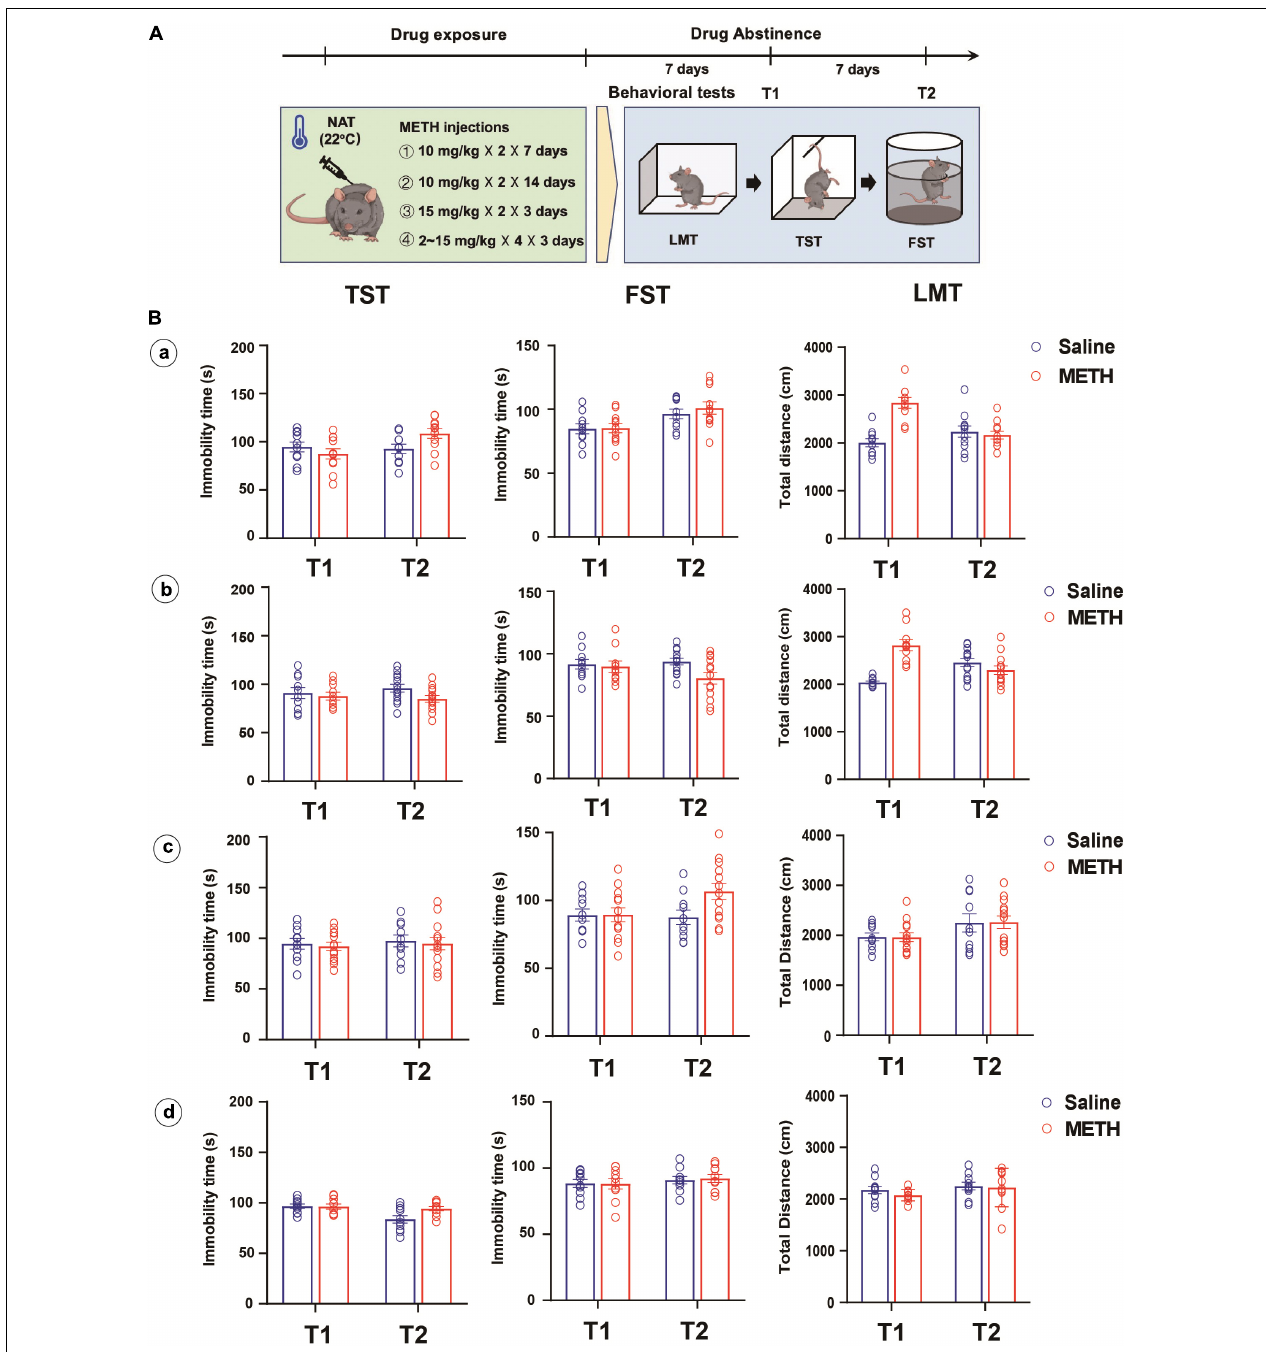
FIGURE 2 | Longer-term (10 mg/kg × 2, 7 and 14 days), higher dose (15 mg/kg × 4, 3 days) or escalating-dose (2–15 mg/kg, 3 days) regimen of METH treatments under normal ambient temperature (22 ◦ C) failed to induce depression-like behaviors in mice. (A) Timeline of drug treatment and behavioral tests. (B) Different METH treatment procedures ( a: 10 mg/kg × 2, 7 days; b: 10 mg/kg × 2, 14 days; c: 15 mg/kg × 4, 3 days; d: 2, 2, 5, 5, 5, 5, 10, 10, 10, 10, 15, and 15 mg/kg in 3 days) were performed in mice, and the depression-like behaviors and locomotion were tested at 7 (T1) and 14 (T2) days after METH exposure ( a: n = 10 and 11; b: n = 10 and 12; c: n = 10 and 13; d: n = 10 and 10). Data are expressed as the mean ± SEM.